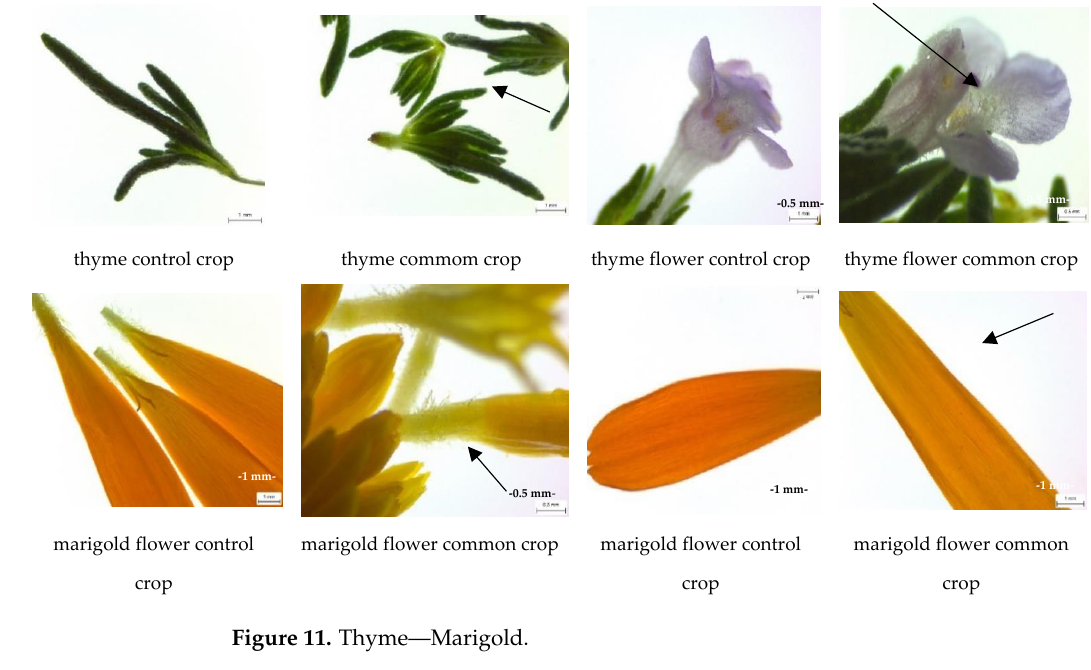
Figure 11. Thyme — Marigold. The rosemary-thyme group had the following changes - the rosemary leaf had a higher number of glandular hairs with volatile oil than the control crop, and the thyme leaf and flower exhibited similar changes (Figure 12).